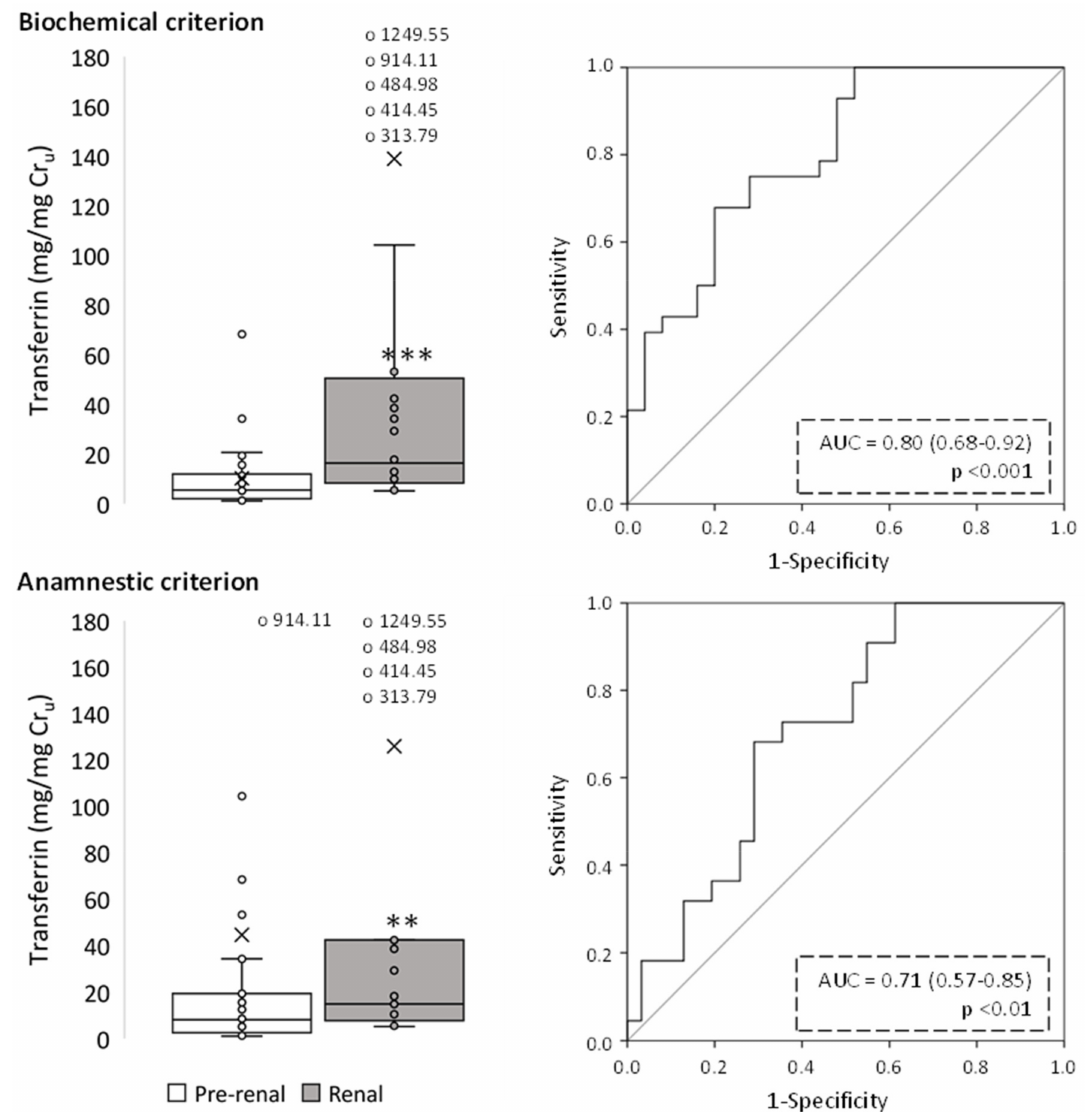
Figure 7. Urinary transferrin levels of pre-renal and renal AKI patients following classification by biochemical and anamnestic criteria, shown as box plots ( left panels) representing median values in mg of urinary transferrin per mg urinary creatinine (Cr u ), and ROC curves ( right panels). AUC: area under the ROC curve showing the pre-renal/renal classification efficacy of urinary transferrin. The × in box plots represents the median value. **, p < 0.01; ***, p < 0.001. The binary logistic regression analysis with which we intended to obtain the best combination of biomarkers that would allow for discrimination between patients with renal AKI from those with pre-renal AKI (Table 2) generated a significant model, after applying the biochemical classification criteria, for transferrin (specificity: 81.8%; sensitivity: 61.5%; percentage of success: 70.8%). The model’s sensitivity and percentage of success improved when including the biomarker NAG (specificity: 77.3%; sensitivity: 76.9%; percentage of success: 77.1%). In contrast, no significant logistic regression model was obtained when the anamnestic classification criterion was